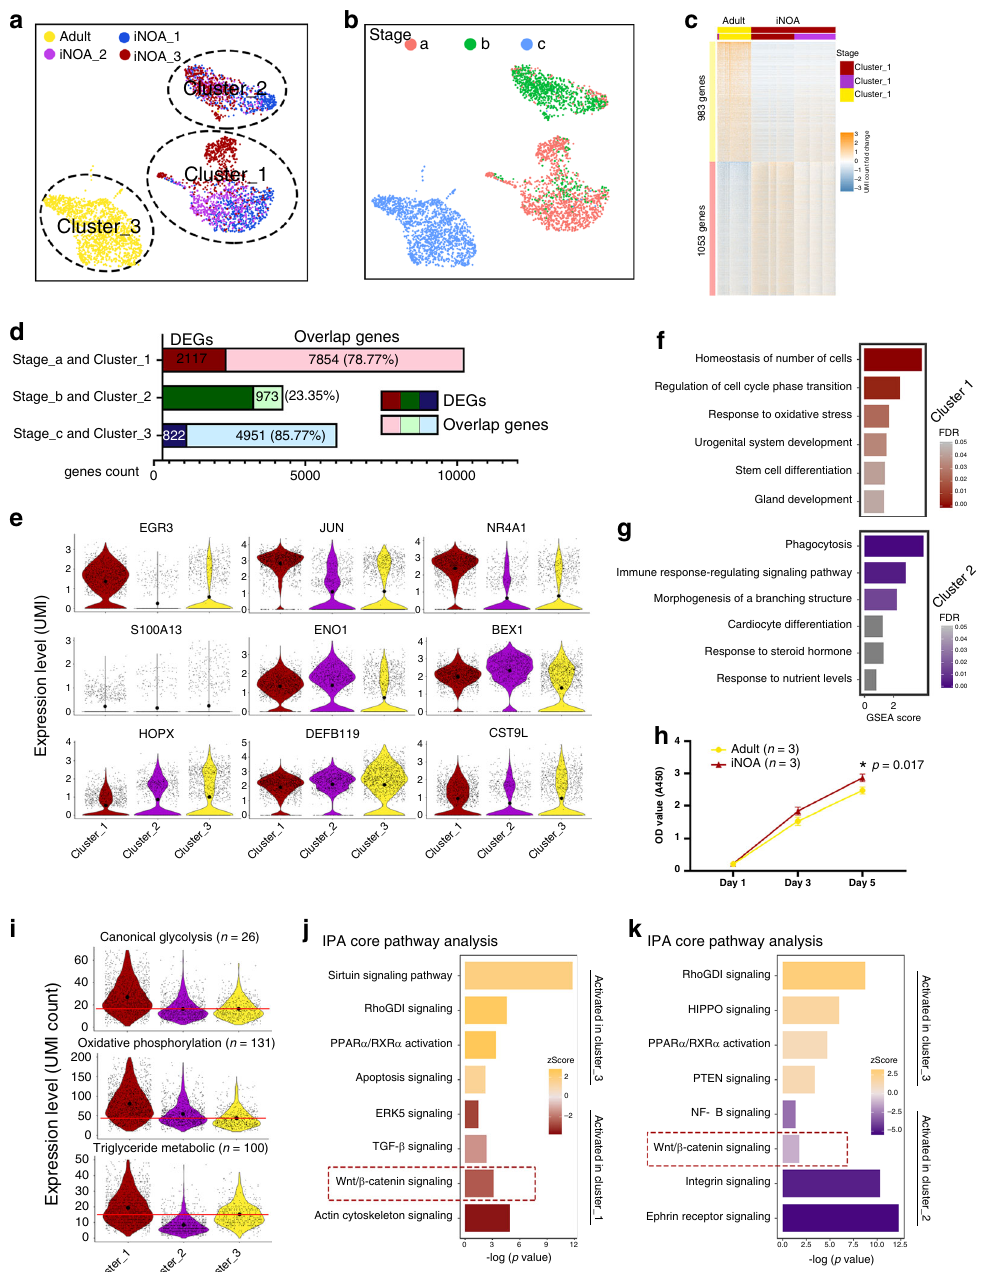
Fig. 5 The changes in expression pattern showed the heterogeneity and maturation arrest of iNOA Sertoli cells. a , b UMAP plot showing the heterogeneity among iNOA Sertoli cells; a clear difference is observed between iNOA and normal adult Sertoli cells. c Heatmap of DEGs between healthy adult and iNOA Sertoli cells. d The percentage of overlap genes between iNOA (cluster 1 and cluster 2) and normal developmental Sertoli cells in Stage_a or Stage_b, and between normal adult (cluster 3) and other normal Sertoli cells in Stage_c. e Violin plot of the expression levels of candidate stage-speci fi c markers in three Sertoli cell clusters. The upper row shows Stage_a markers; the middle row shows Stage_b markers, and the bottom row shows Stage_c markers. The larger black dots in each violin plot column represent the mean value. f , g GSEA terms enriched in f cluster 1 and g cluster 2 iNOA Sertoli cells, shown as barplot. The GSEA score is presented on the x -axis, and the gradient of red indicates low to high FDR values. h iNOA Sertoli cells proliferated faster than normal adult Sertoli cells in vitro, as shown by CCK-8 assay. Data shown as mean ± SD from three biological independent samples and two times independent experiments, statistical analysis made by two-tailed, Student ’ s t -test; the con fi dence interval is 95%. * p < 0.05 (comparing with normal adult). i Violin plot of the expression levels of energy metabolism-related genes in three Sertoli cell clusters. The larger black dots in each violin plot column represent the mean value. j , k Pathways terms of IPA enriched in j cluster 1 and k cluster 2 compared with normal adult Sertoli cells, shown as barplot. The p -value is presented on the x -axis, and the gradient of two colors indicates low to high activation scores in the two